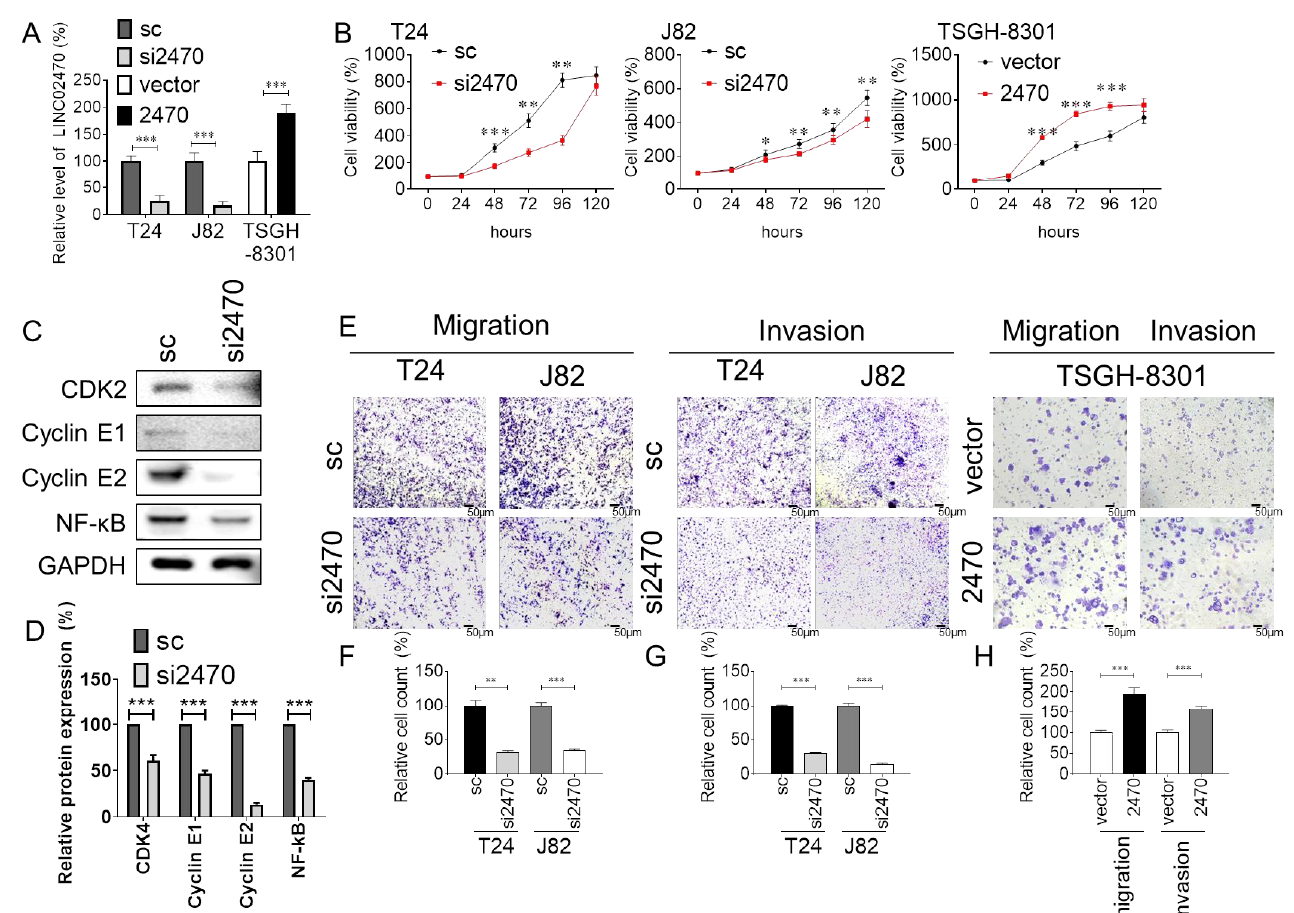
Figure 2. ( A ) The relative expression levels of LINC02470 in T24 and J82 cells transfected with LINC02470 siRNAs (si2470) or scrambled negative control (sc) and in TSGH-8301 cells transfected with pCMV-LINC02470 (2470) or pCMV vector (vector) control (normalized to GAPDH expression). ( B ) Relative cell viability at 0 h, 24 h, 48 h, 72 h, 96 h, and 120 h was compared between T24 and J82 cells transfected with si2470 or sc and between TSGH-8301 cells transfected with 2470 or vector. ( C ) The protein levels of the G1-S transition markers CDK2, cyclin E1, and cyclin E2 and the survival signaling marker NF- κ B were determined using Western blotting in T24 cells transfected with si2470 or sc. ( D ) Bar chart showing the relative protein levels, which were normalized to GAPDH; the sc group was used as the comparative baseline. ( E ) LINC02470 effects on cell migration and invasion abilities were analyzed with Transwell assays. T24 and J82 cells transfected with si2470 exhibited fewer migrated and invaded cells than the sc group. ( F – H ) Bar charts showing the relative migrated/invaded cell numbers (* p < 0.05, ** p < 0.01, *** p < 0.001, Student’s t -test).